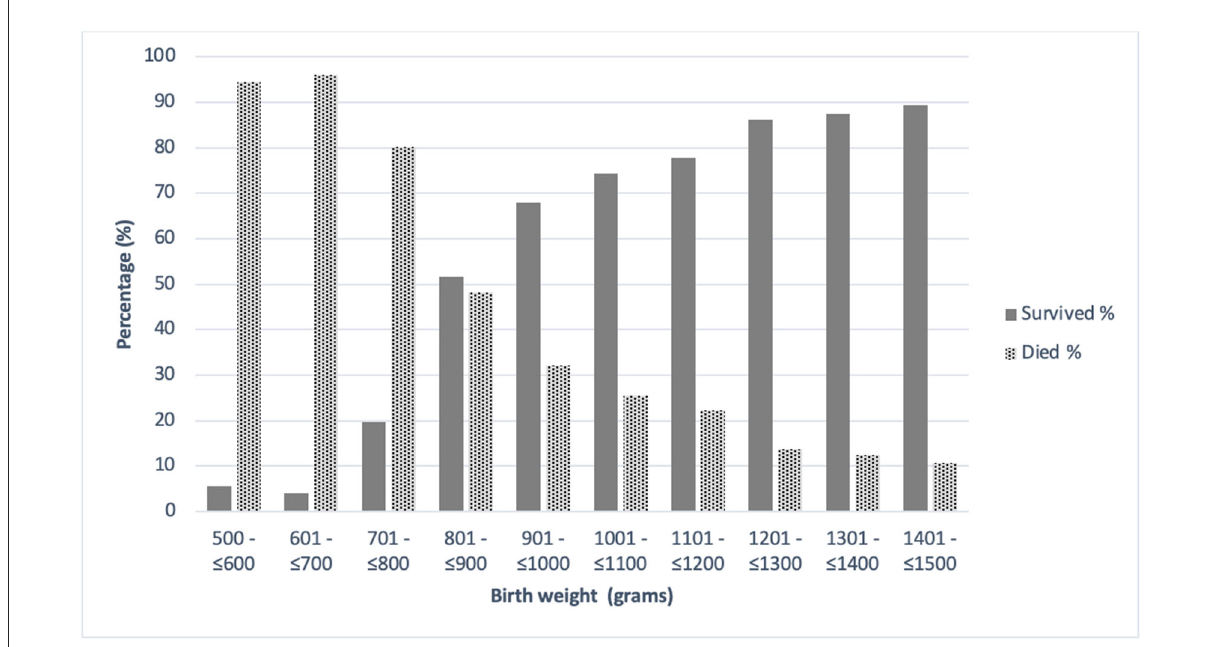
FIGURE1 Survival by weight category. Survival of very low birth weight infants by birth weight